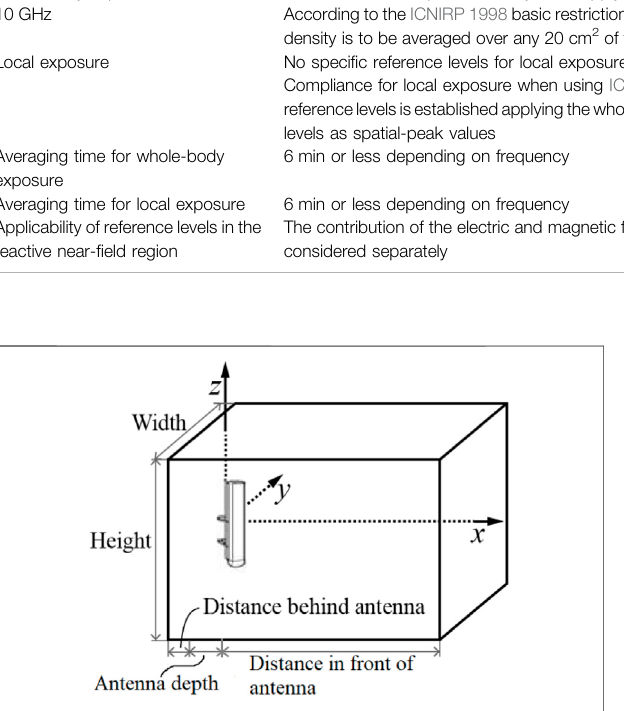
FIGURE 1 | Box-shaped structure specifying the compliance boundary surrounding the BS